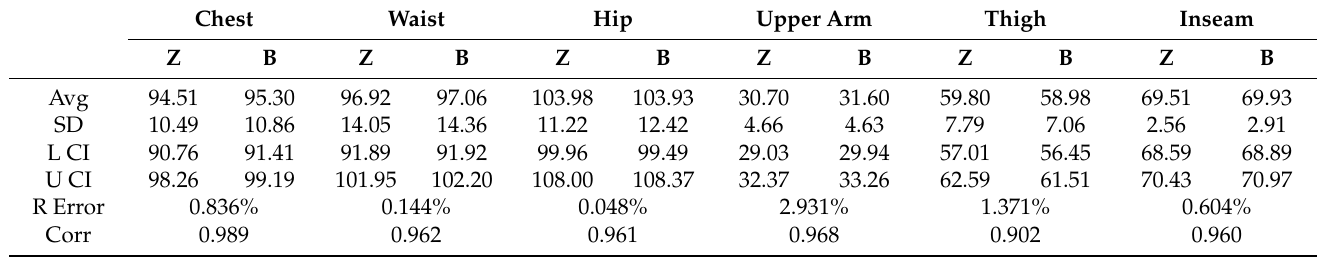
Table 11. Comparing the average results of chest, waist, hip, upper arm circumference, thigh, and inseam, with the standard deviation, the lower and upper bounds of the 95% confidence interval, the relative error, and the correlation between the Z-Size Ladies statistical value and the circumference values measured cross-sectionally on 3D modelling for the case of pregnant women.